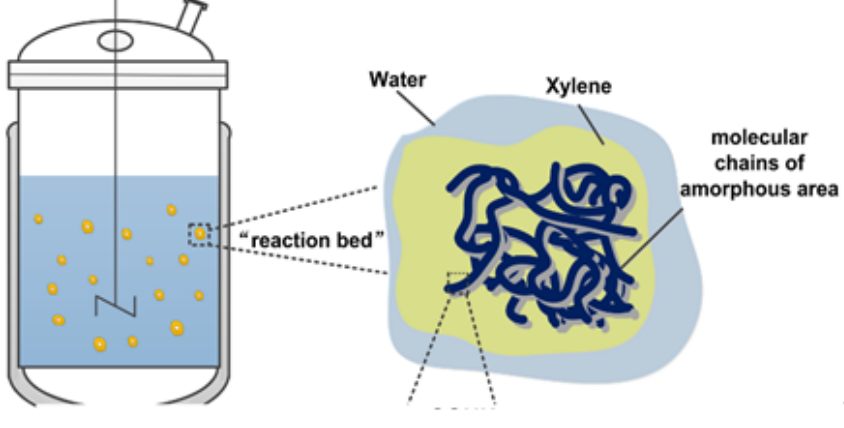
Figure 2. The suspension grafting reaction system.